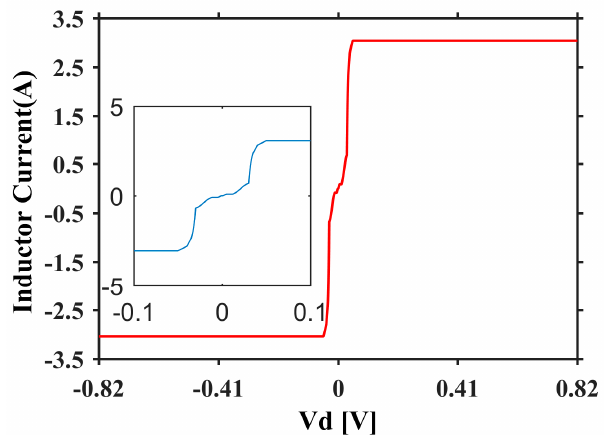
Figure 11. Inductor current with input V d at an OCV of 3.3 V.